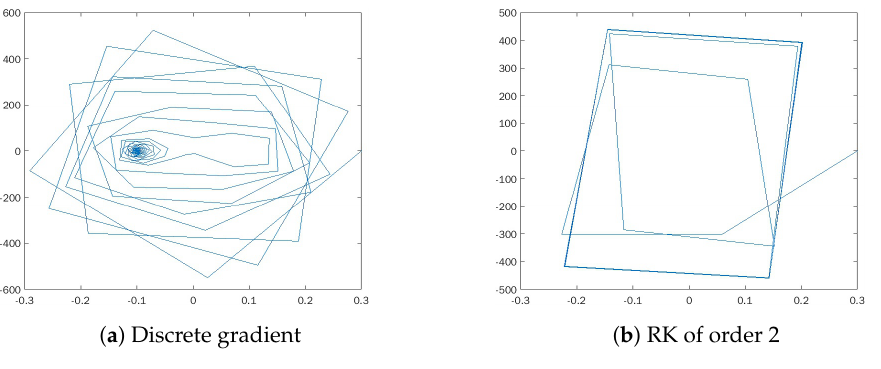
Figure 4. Phase portrait for h = 10 − 3 .